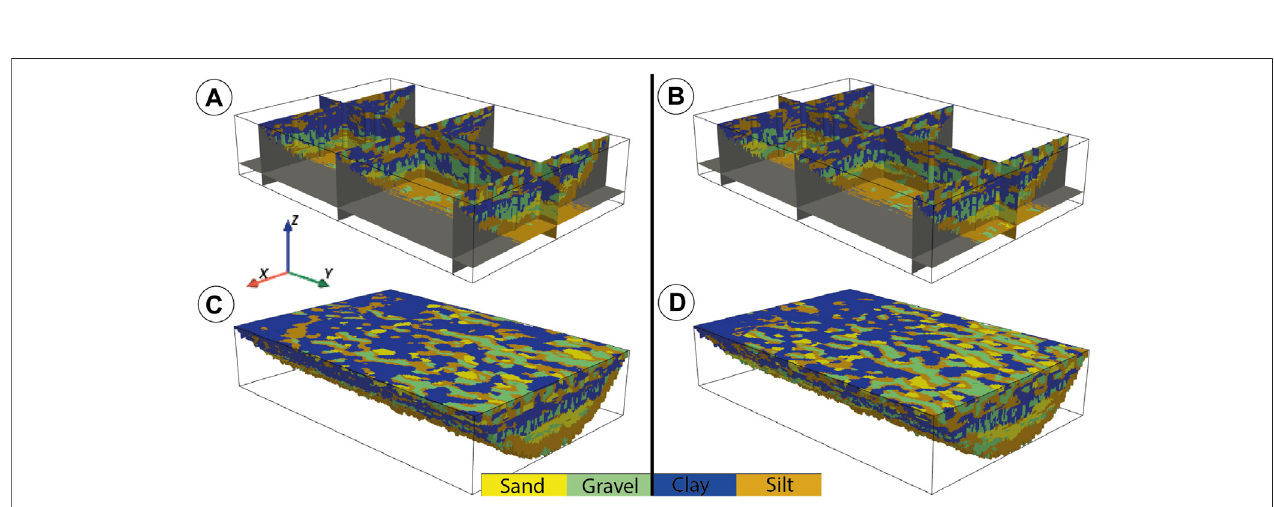
FIGURE 7 | Two realizations (A,B) of the lithofacies (2nd step of the ArchPy simulations) for the synthetic case. (C,D) are 3D bloc realizations of (A) and (B) , respectively. The simulations used the respective corresponding units of Figure 6 as simulation domains. Vertical exaggeration = 3x.